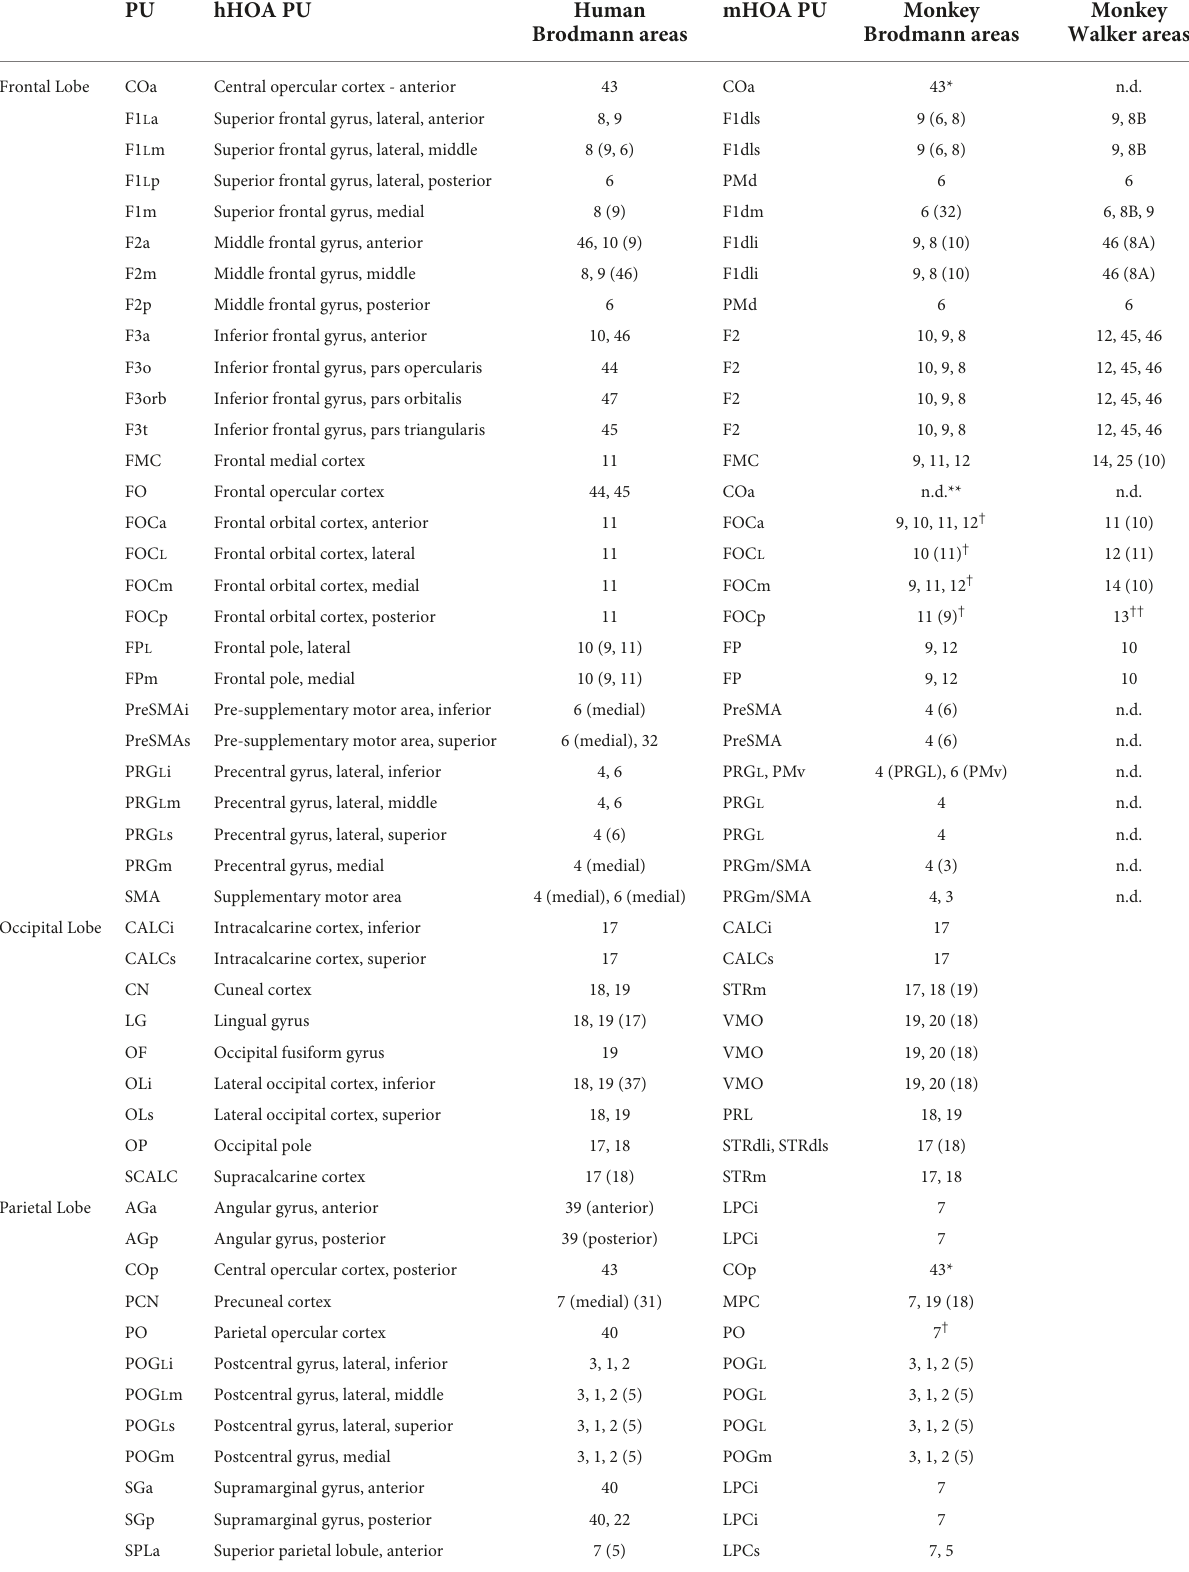
TABLE 11 HOA-ComPaRe Equivalences between human (hHOA) and macaque (mHOA) Harvard-Oxford Atlases. PU hHOA PU Human mHOA PU Monkey Monkey Brodmann areas Brodmann areas Walker areas Frontal Lobe 43 COa 43*